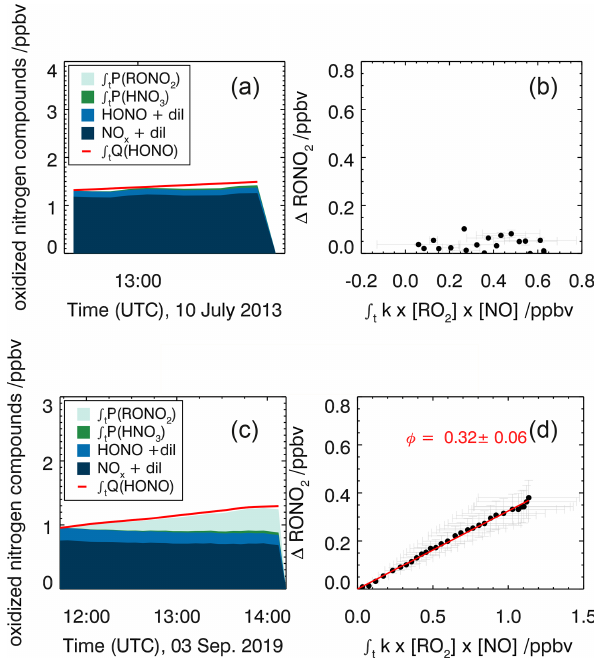
Figure 6. Time series of nitrogen oxide species in the experiments with methane (10 July 2013, a ) and α -pinene (3 September 2019, c ). The red lines in panels (a) and (c) are time-integrated HONO emis- sions calculated as described in the text. NO x and HONO concen- trations were measured; the time-integrated NO 2 loss by HNO 3 for- mation from the reaction of NO 2 with OH and the time-integrated NO 2 loss by RONO 2 formation from the reaction of RO 2 with NO were calculated as described in the text. The alkyl nitrate yield ( (cid:56) RONO2 ) is determined from the regression analysis (red line, d ) using Eq. (8). Errors are derived from error propagation of measure-